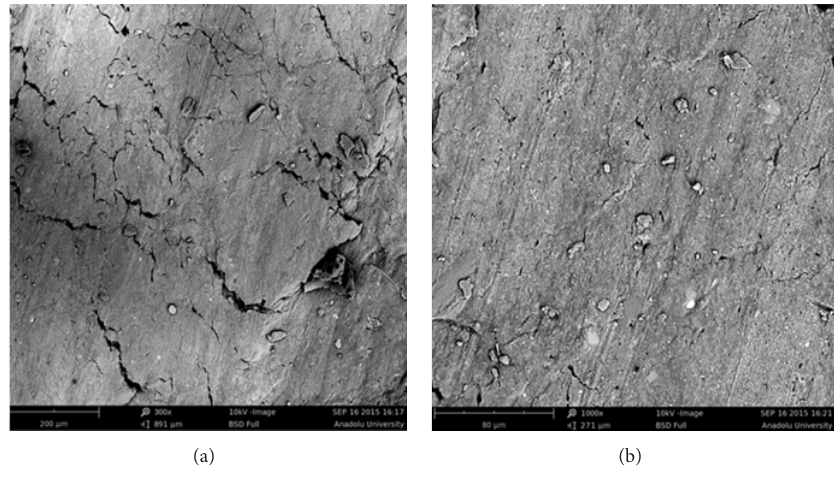
Figure 6: SEM images of PK-BTM30CW70 exposed to DW: (a) 300x; (b) 1000x.